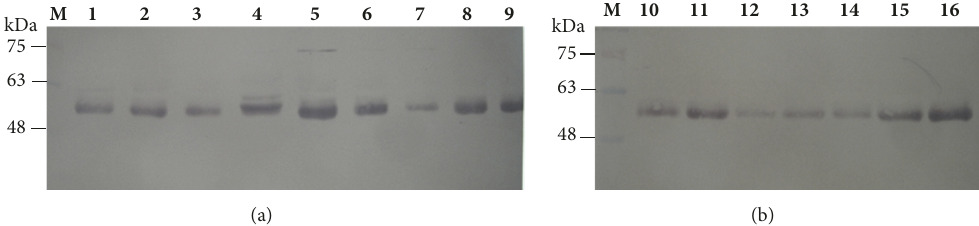
Figure1:WesternblotanalysisofproteinsusingMMP-1antibody.Proteinswereanalysedon10%w/vSDS-polyacrylamidegels.M:prestained protein markers, lanes 1 -9 (a), 10-16 (b): 50 𝜇 g total proteins.